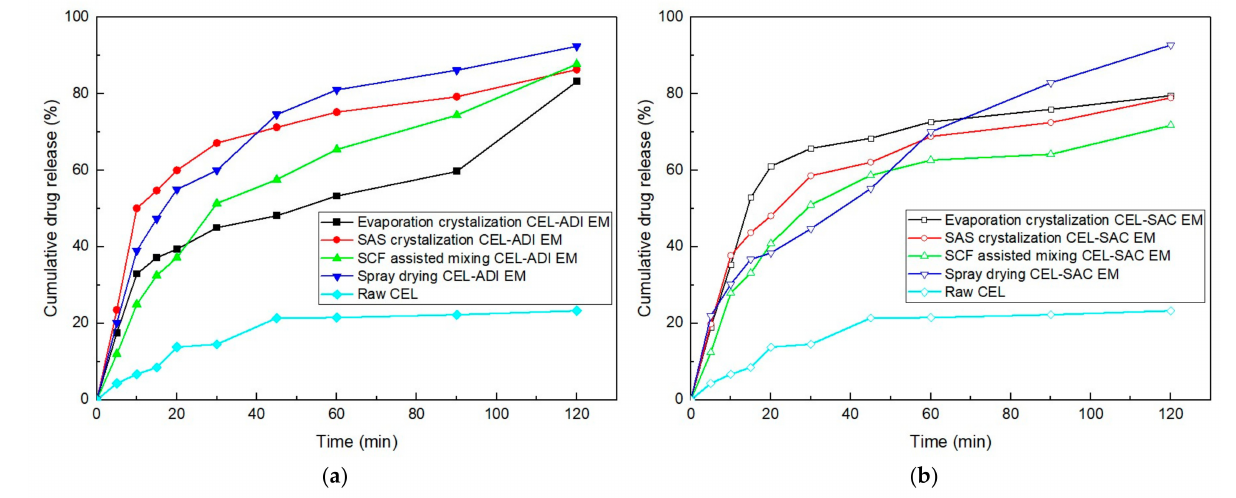
Figure 9. Dissolution profile of CEL EM: ( a ) CEL-ADI EM; ( b ) CEL-SAC EM in comparison with raw CEL dissolution profile. Data were performed as mean (n =